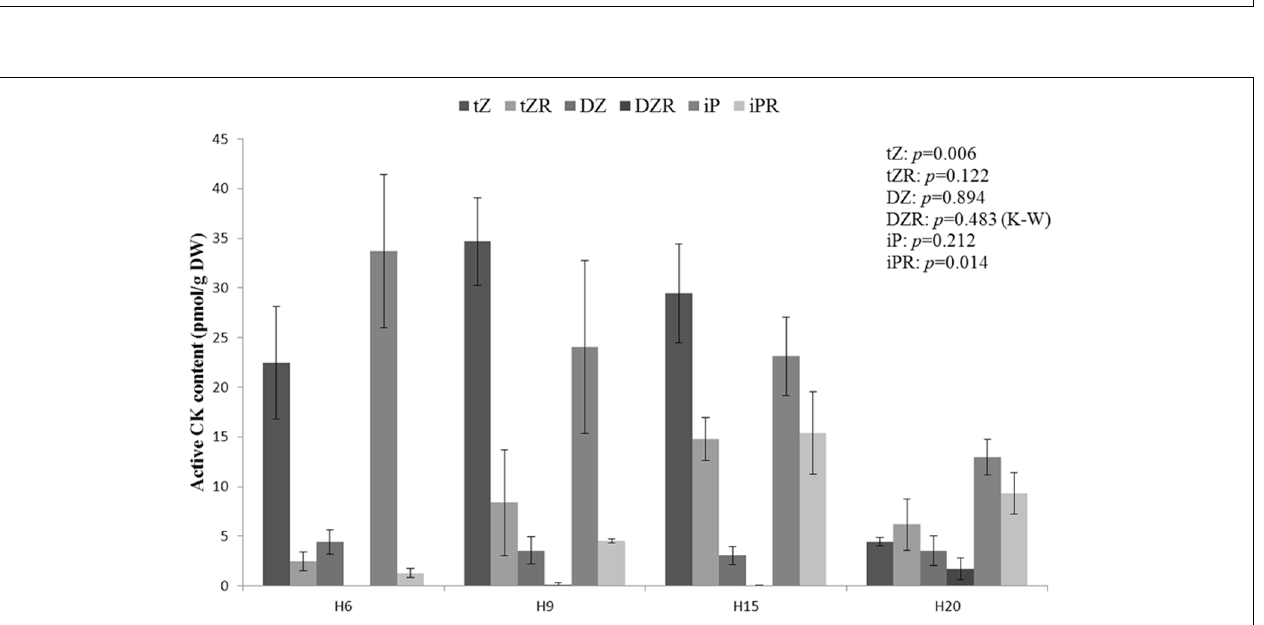
Frontiers in Plant Science |